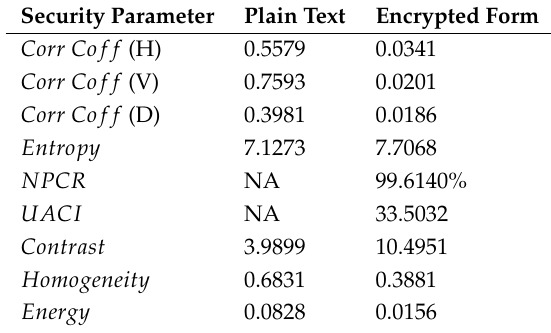
Table 4. Egress data.